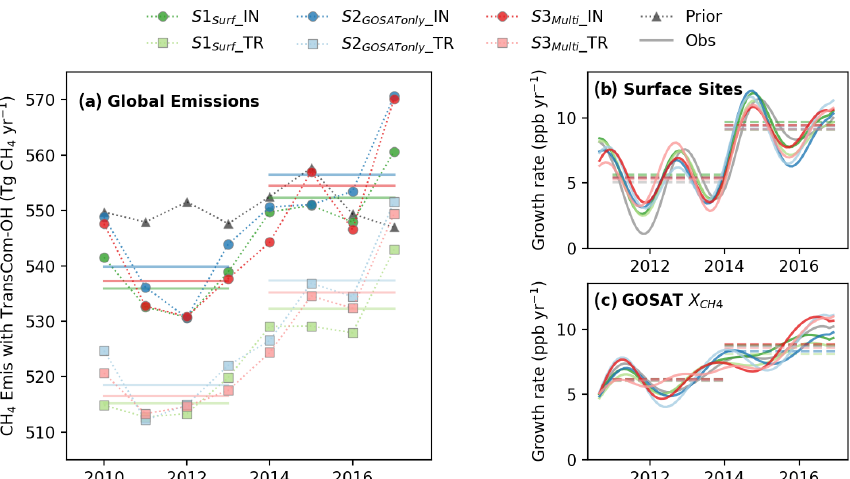
Figure 2. Global CH 4 emissions and atmospheric growth rates from 2010 to 2017. (a) Surface CH 4 fluxes of the prior (black triangles) and posterior estimates (color coded). The circles represent versions using INCA-OH (denoted with IN as suffix), while the squares represent versions using TransCom-OH (denoted with TR as suffix). The horizontal lines mark the average emissions of the two periods, 2010–2013 and 2014–2017. (b) Deseasonalized methane growth rates smoothed for variations shorter than 90d in the posterior model states sampled at the 103 surface stations included in inversion S1. (c) X CH growth rates in the posterior model states sampled at the measurement time and 4 location of GOSAT retrievals included in inversions S2 and S3.